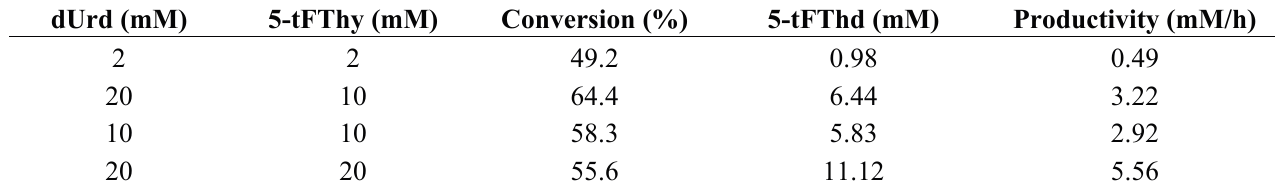
Table 4. Effect of substrate molar ratio and concentration on the enzymatic synthesis of dUrd